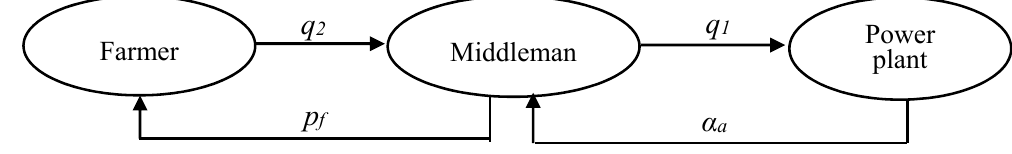
Figure 3. Decision variables in biomass supply chain.